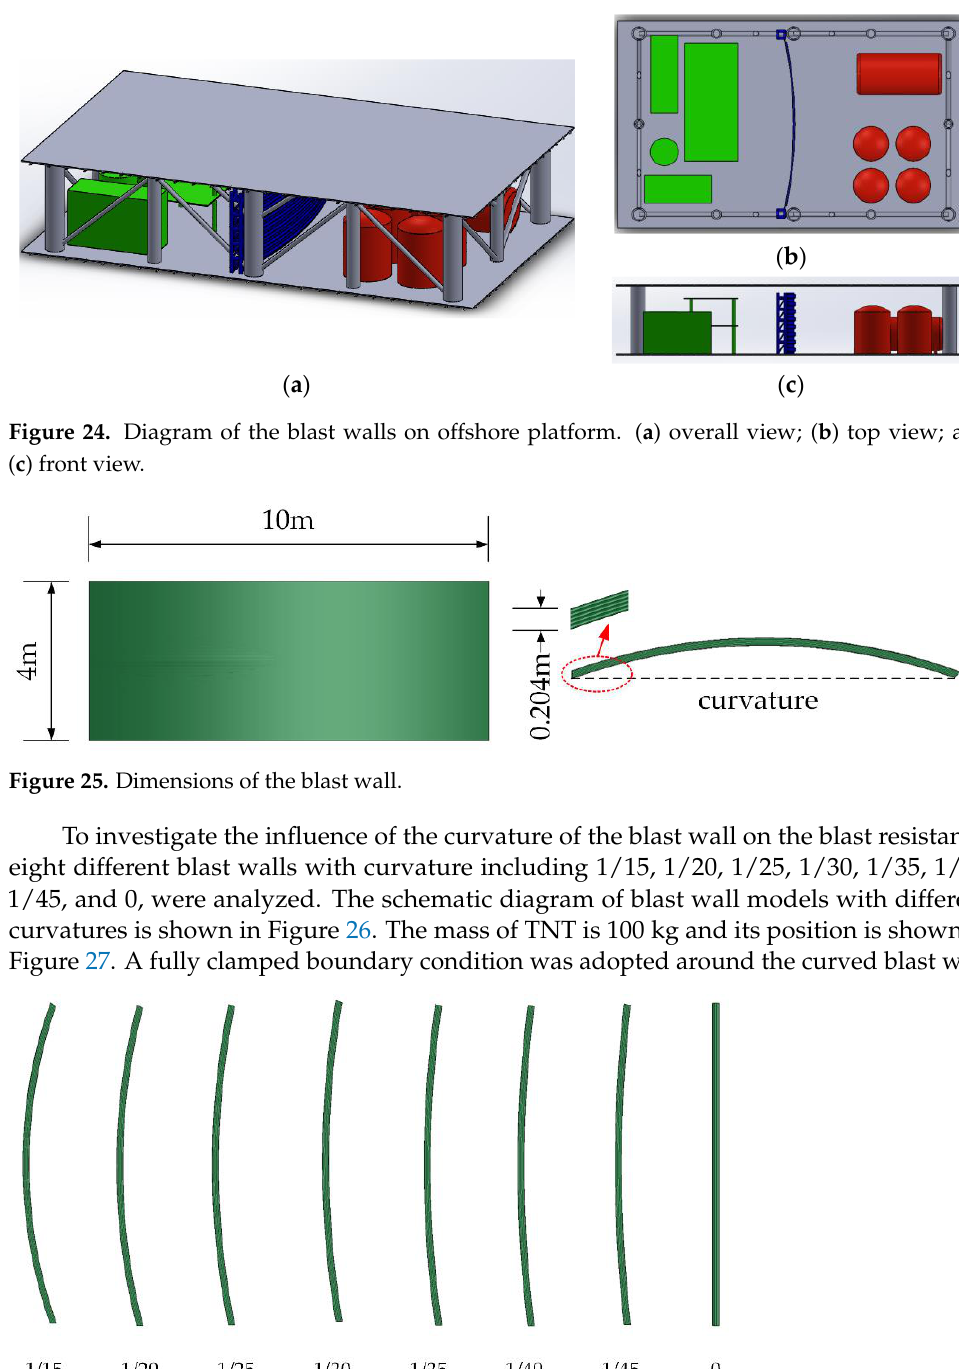
Figure 26. Configurations of blast wall with different curvature (m − 1 ).